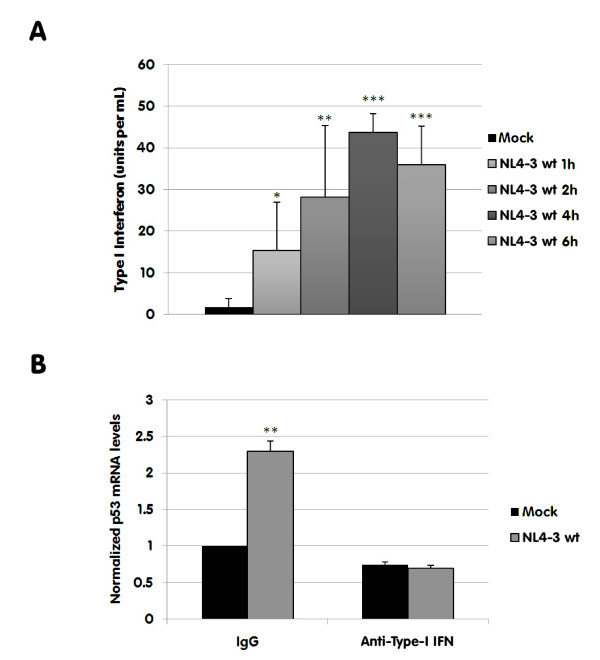
Virus-induced type-I IFN secretion and blocking experiments with anti-IFN-α and -β antibodies. (A) Cells were either left uninfected or infected with NL4-3 wt for the indicated times. Thereafter, .HEK-Blue™ IFN-α/β cells were exposed to the collected cell-free supernatants for 24 h and type-I IFN levels were quantified according to manufacturer's instructions. (B) The purified cell population highly enriched in CD4+ T lymphocytes was either left uninfected or infected with NL4-3 wt for 24 h. In some samples, neutralizing antibodies against human IFN-α and IFN-β were added in equal quantities (a final concentration of 1 μg/ml was used). Controls consisted of cells treated with isotype-matched irrelevant antibodies (IgG). Thereafter, total RNA was isolated and p53 mRNA levels were estimated by qRT-PCR. The data shown represents the mean ± standard deviations of triplicate samples and are representative of three independent experiments. Asterisks denote statistically significant differences from the uninfected control cells (*, P < 0.05; **, P < 0.01; ***, P < 0.001).